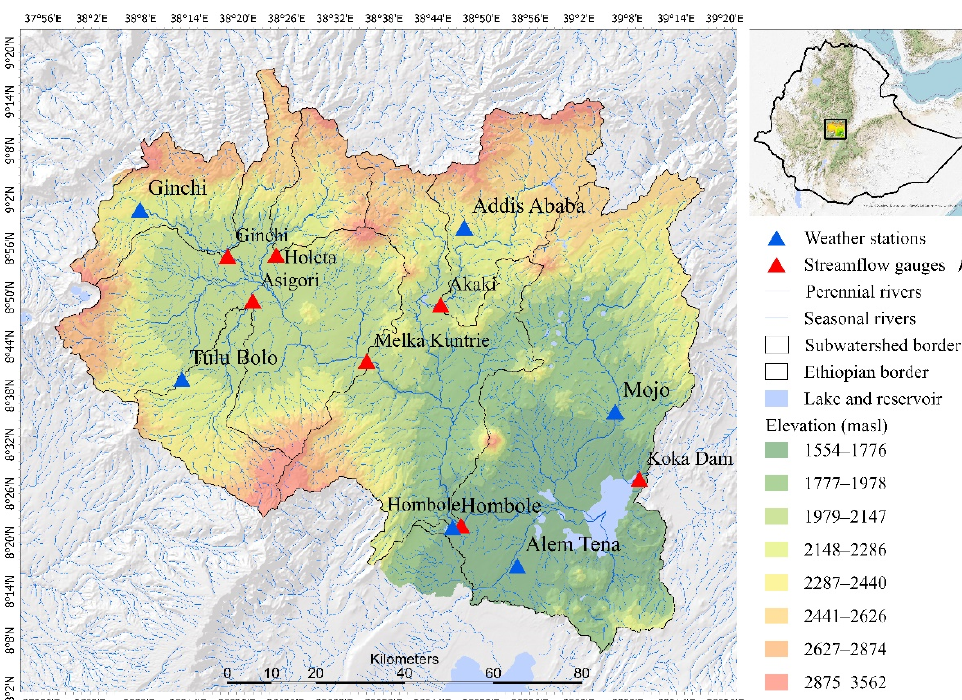
Figure 1. Map of the Upper Awash River Basin.